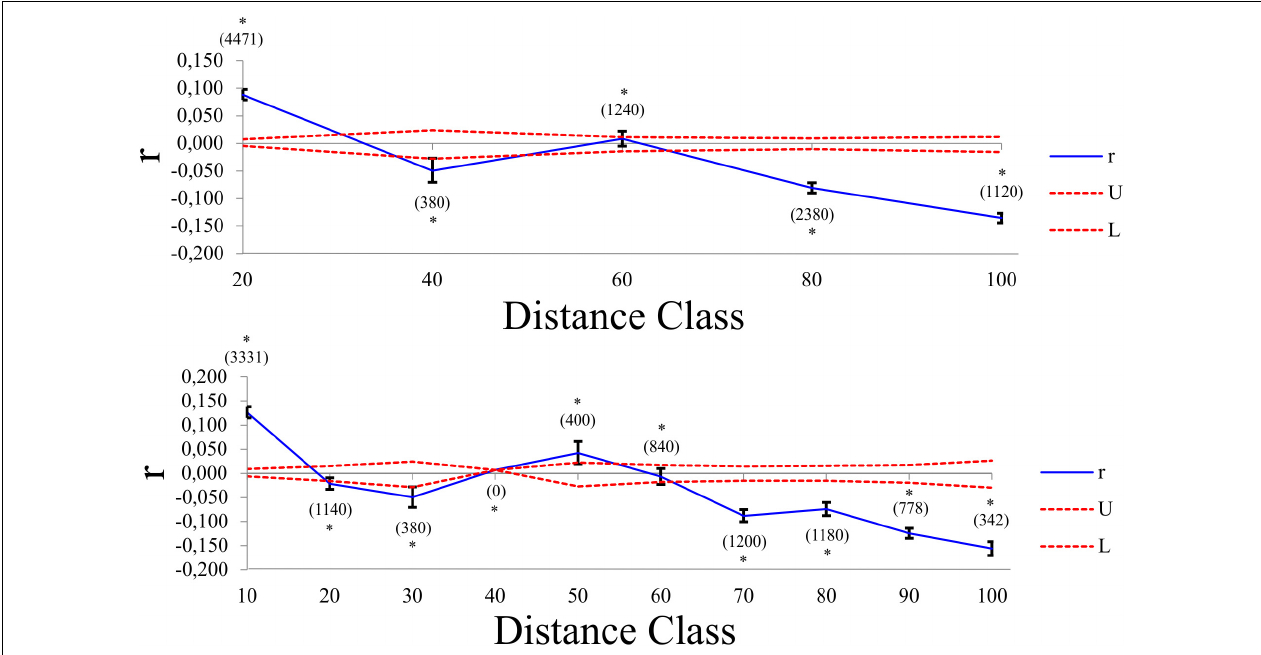
FIGURE 6 | Multiallelic correlograms (blue line) showing the spatial genetic structure of M. dolomieu across two distance classes (10 and 20 km). The 95% null hypothesis confidence intervals are indicated by the red dotted lines. Positive values represent individuals more genetically similar than expected in a given distance class, while negative values imply that individuals in that distance class are less genetically similar than expected. The value in brackets denote the number of pairwise comparisons. The asterisk denotes the statistically significant pairwise relatedness in a specific distance